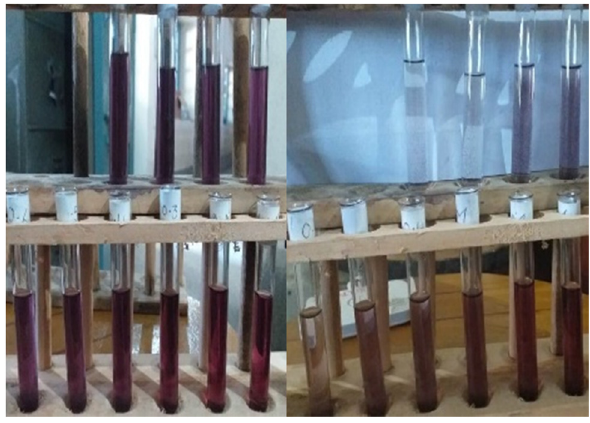
Figure 9: UV - Visible data of e ff ect of NaCl on sa ff ron stigma AuNPs ( SS - AuNPs ) .